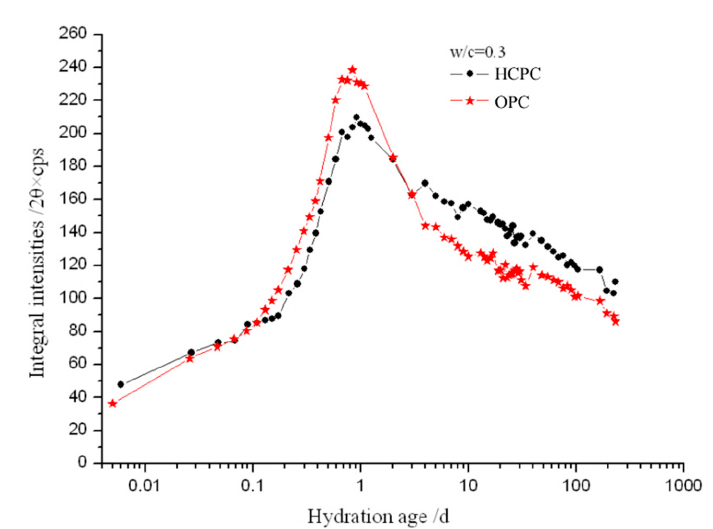
Figure 4. The development of the integral intensities of the AFt’s characteristic diffraction peak in the hydrated HCPC and OPC with w/c = 0.3. hydrated HCPC and OPC with w / c =